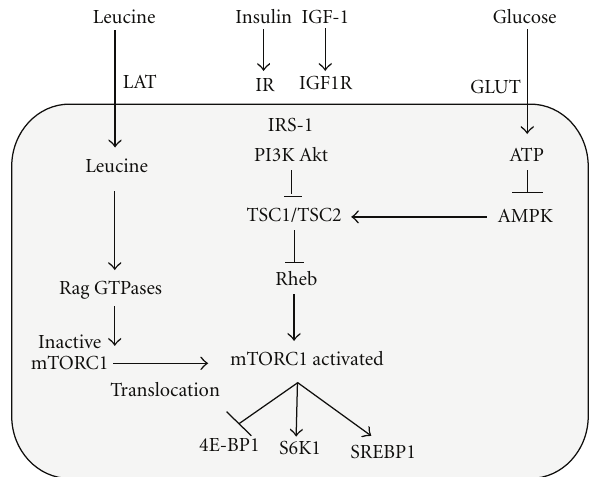
Figure 1: Simplified model of leucine-, insulin/IGF-1-, and glucose-dependent activation of mTORC1; Akt: Akt kinase; AMPK: AMP-activated protein kinase; ATP: adenosine triphosphate; 4E- BP1: eukaryotic initiation factor (eIF) 4E-binding protein 1; GLUT: glucose transporter protein; IGF-1: insulin-like growth factor 1; IGF1R: IGF-1 receptor; IR: insulin receptor; IRS-1: insulin receptor substrate 1; LAT: L-type amino acid transporter; mTORC1: mammalian target of rapamycin complex 1; PI3K: phosphoinositol- 3 kinase; Rheb: ras homolog enriched in brain; S6K1: p70 S6 kinase 1; SREBP: sterol regulatory element-binding transcription factor; TSC1: tuberous sclerosis complex 1 (hamartin); TSC2: tuberous sclerosis complex 2